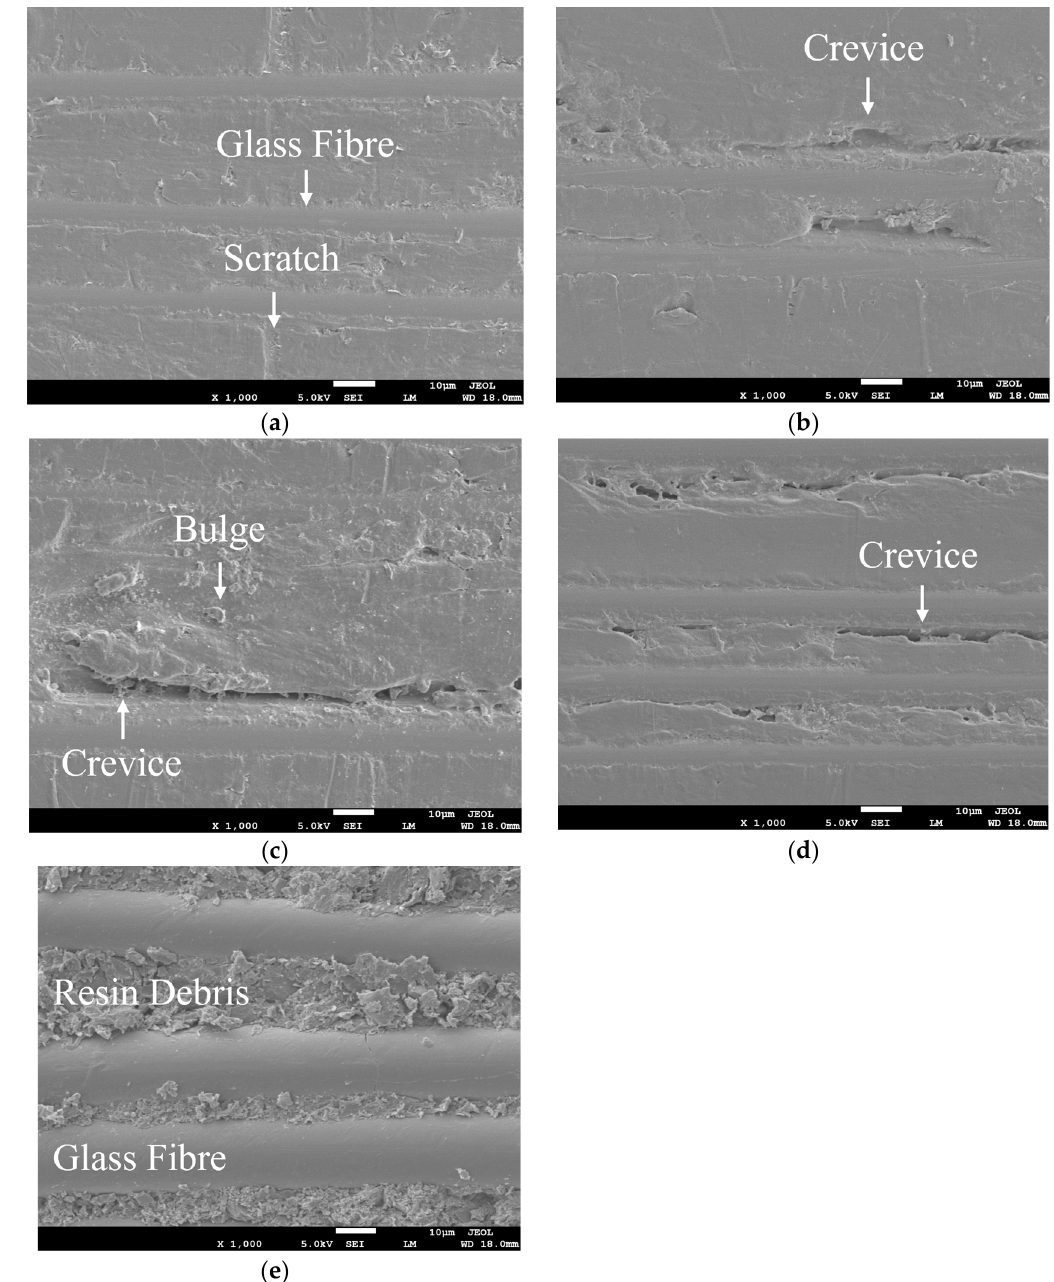
Figure 13. SEM picture of the GF/EP pultruded plate surface: ( a ) no flame treatment; ( b ) one flame treatment; ( c ) three flame treatments; ( d ) five flame treatments; ( e ) seven flame treatments.